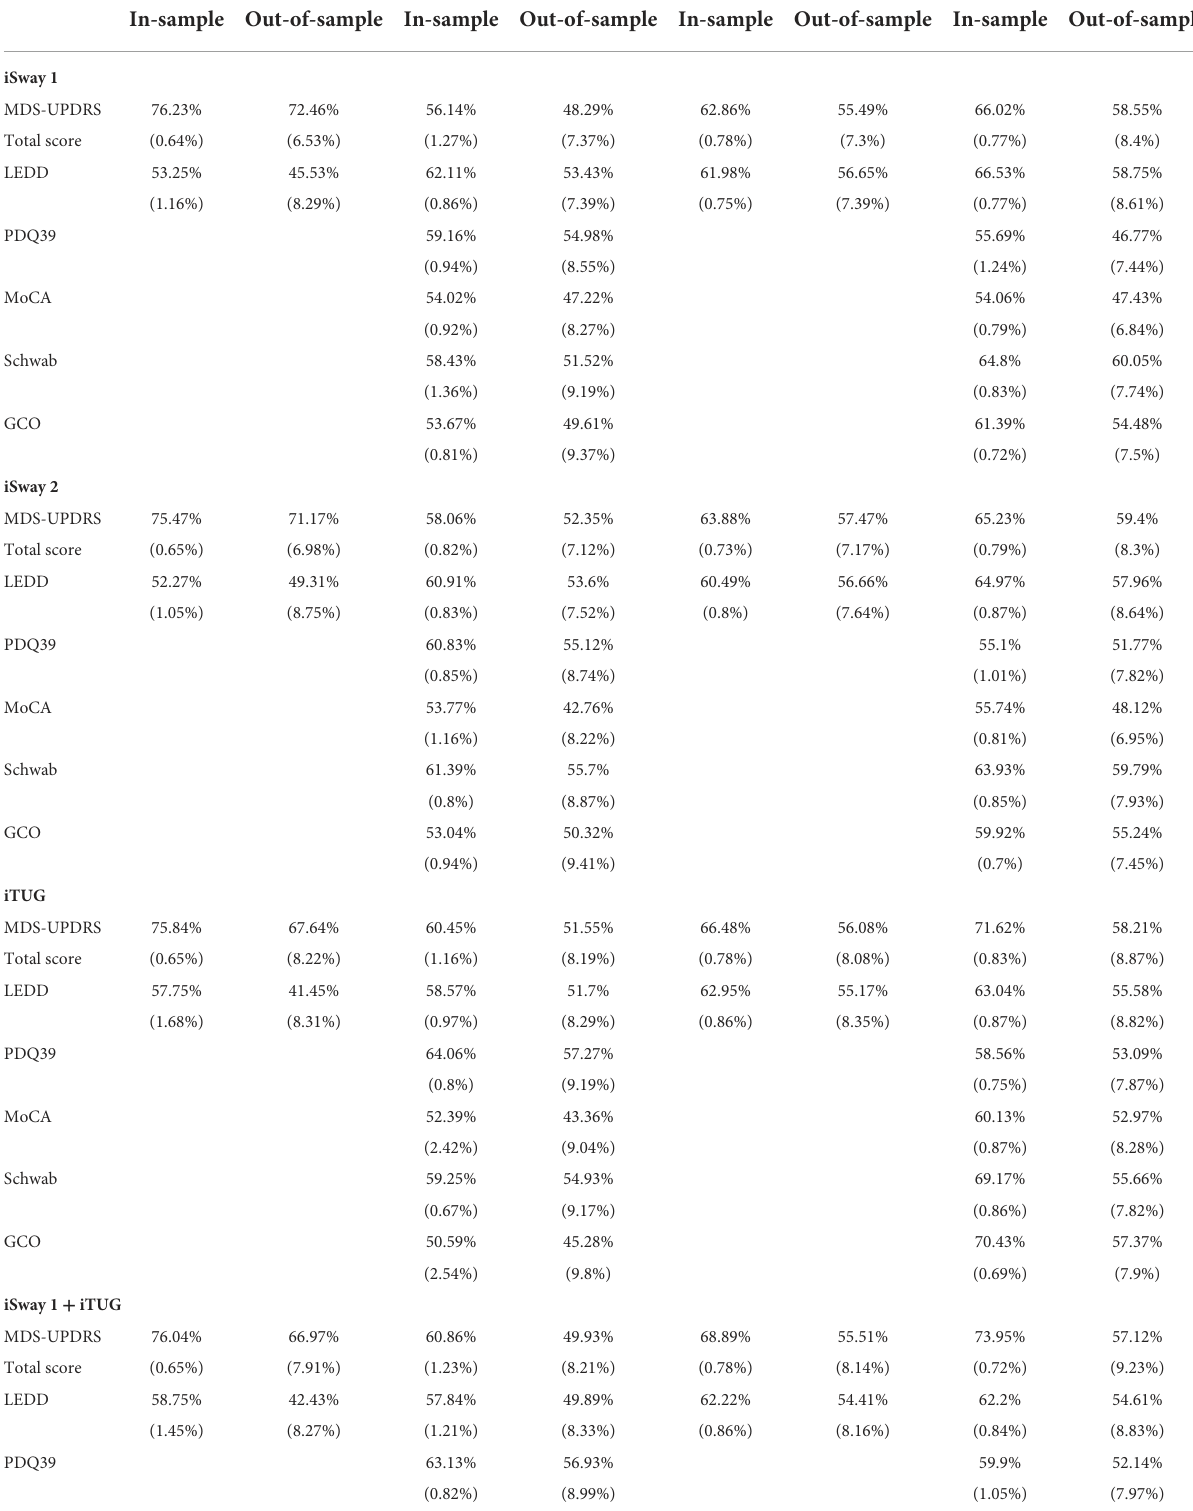
TABLE 3 Average in-sample (training set) and out-of-sample (testing set) accuracy (standard deviation) of ridge regression to predict change in six metrics from baseline to 6, 12, 18, and 24 months. 6-Month